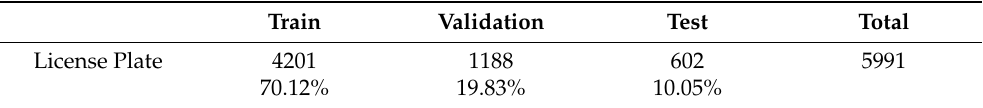
Table 2. Dataset